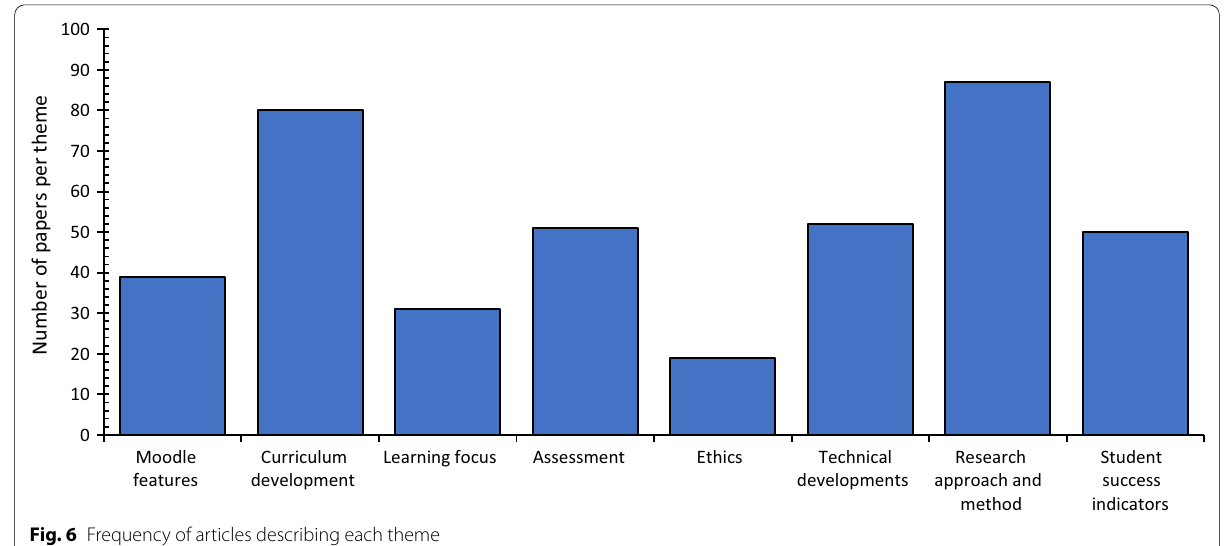
Fig. 6 Frequency of articles describing each theme